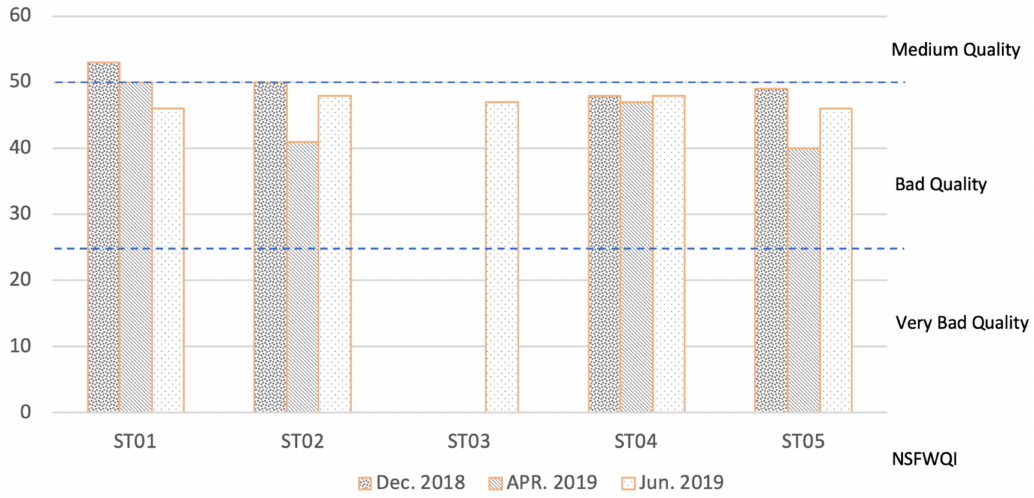
Figure 3. WQI NSF for each